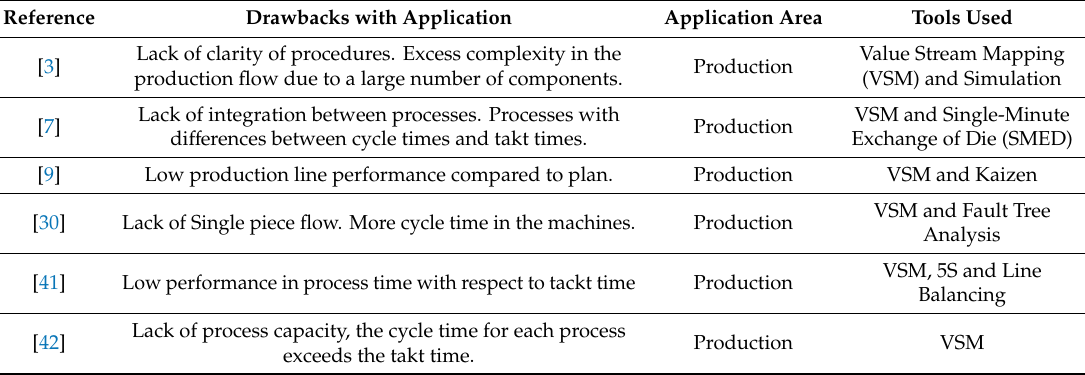
Table 1. Summary of the drawbacks presented for different improvement projects within the automotive industry.